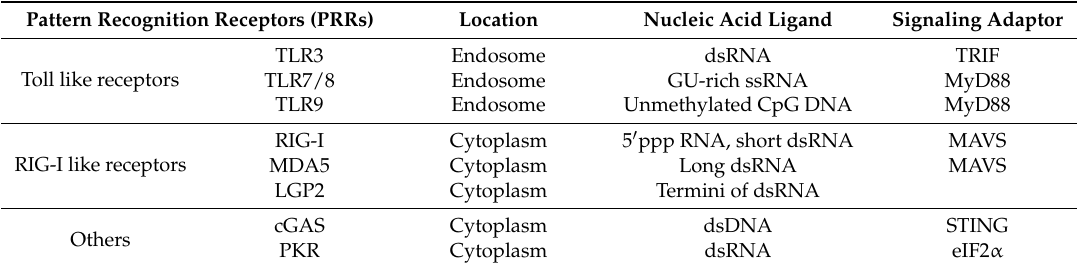
Table 1. Pattern recognition receptors (PRRs) implicated in nucleic acid sensing. Different classes of PRRs operate in distinct cellular compartments and recognize ligands that are absent or rare in the host. Pattern Recognition Receptors (PRRs) Location Nucleic Acid Ligand Signaling Adaptor TLR3 Endosome dsRNA TRIF Toll like receptors TLR7/8 Endosome GU-rich ssRNA MyD88 TLR9 Endosome Unmethylated CpG DNA MyD88 RIG-I Cytoplasm 5 (cid:48) ppp RNA, short dsRNA MAVS RIG-I like receptors MDA5